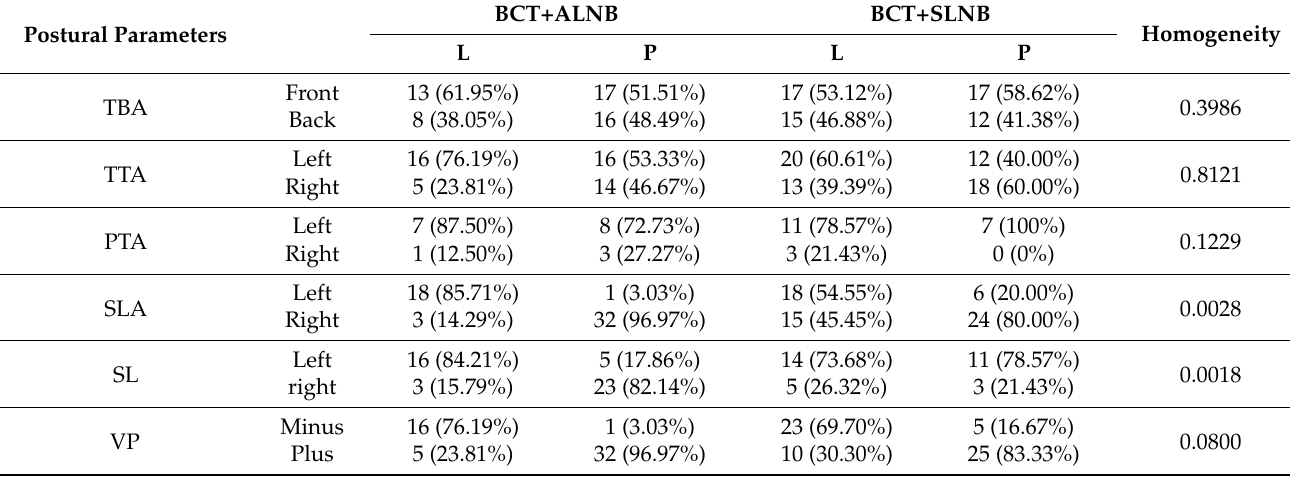
Table 4. Analysis of side-dependent (left or right) parameters in BCT+ALND and BCT+SLNB groups; correlations between groups (BCT+ALND vs. BCT+SLNB). Postural